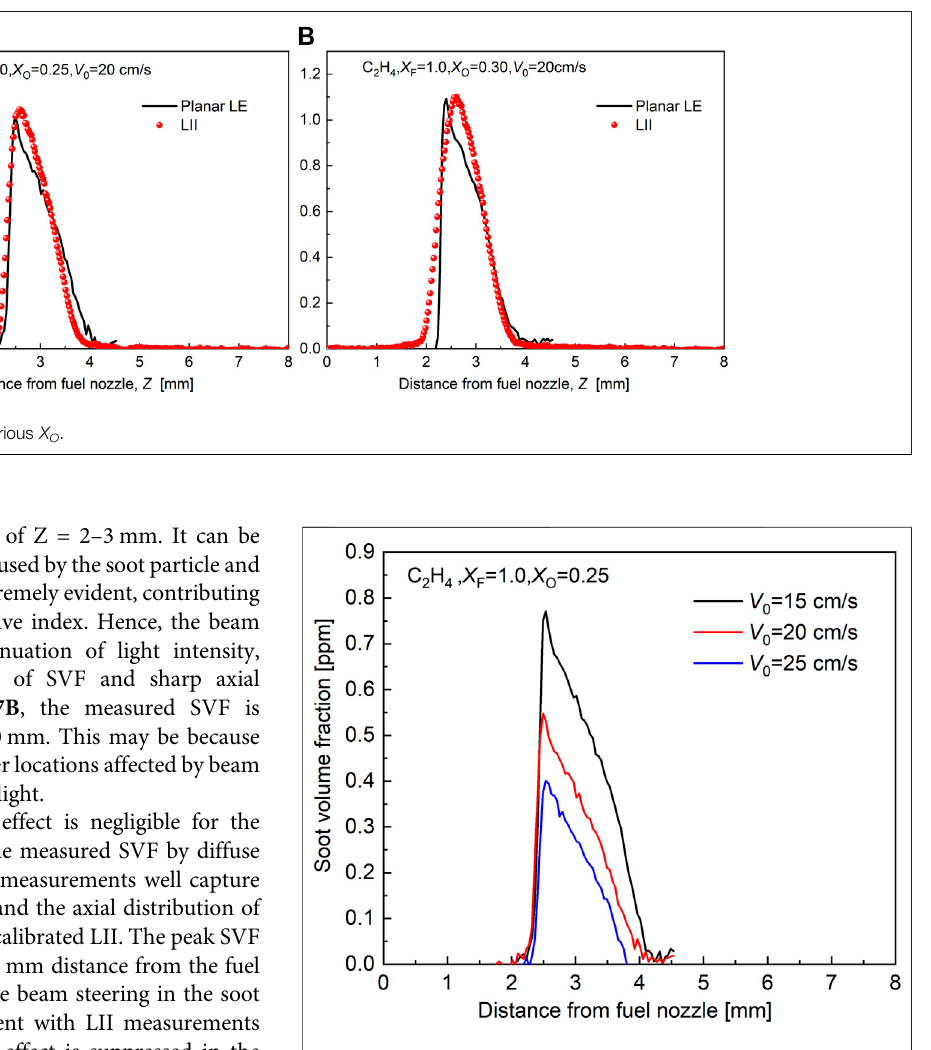
FIGURE 10 | Axial distribution of SVF at various V 0 of fuel and oxidizer